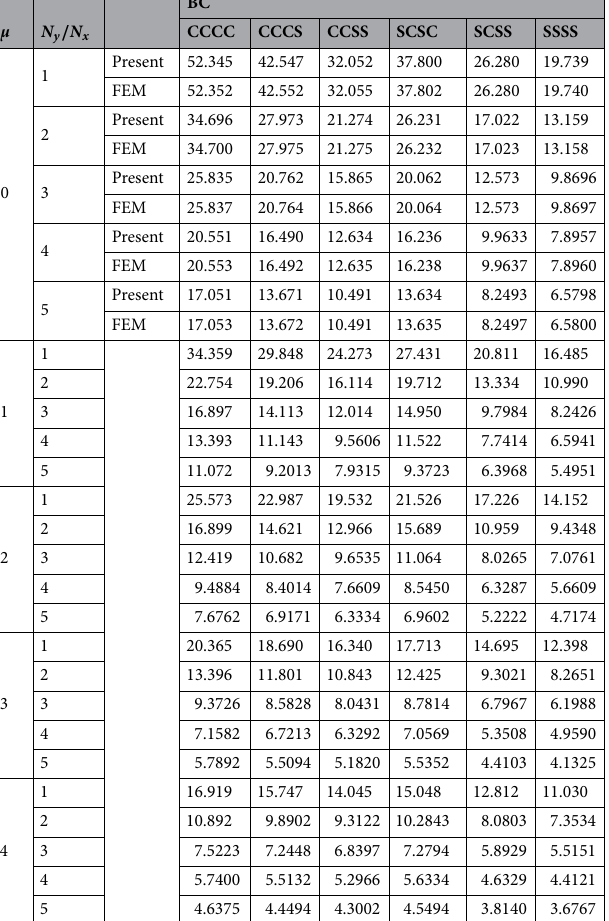
D , of square nanoplates with b = 10 nm under different